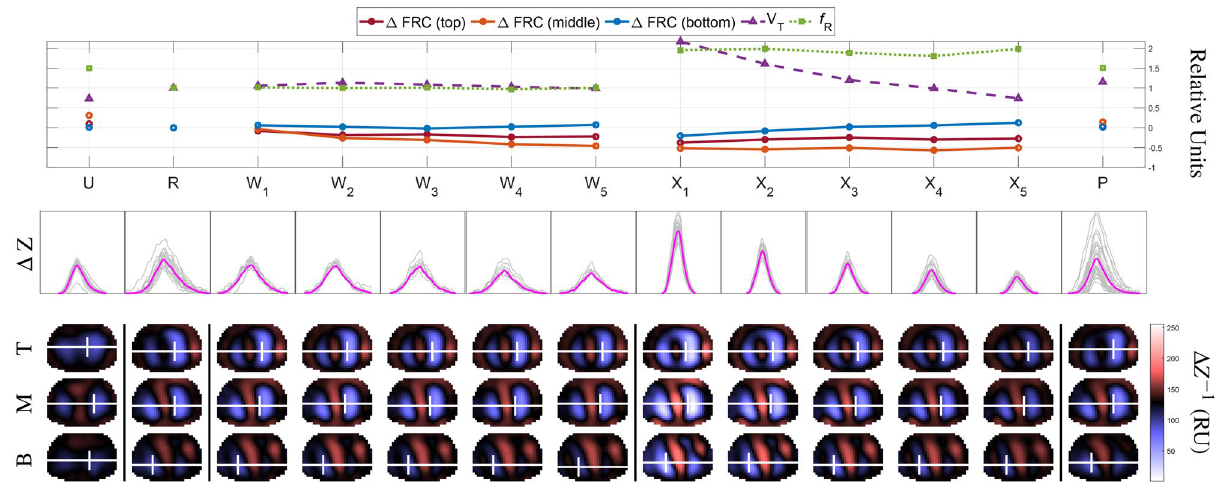
Figure 2. Detailed results for a single subject in the control posture. Experimental phases are labelled as in Fig. 1. Each column in phases W and X were 1-min periods, while phase U, R, and P were a 2-min periods. (Top) plots of (cid:31) FRC the top (red), middle (orange), and bottom (blue) reconstruction planes, V T (purple), and f R (green) for each phase. Error bars were omitted for clarity. Inter-subject variability is shown in Figs. 3 and 4. (Middle) accepted breaths for each phase are plotted in gray along with the average breath in magenta ( (cid:31) Z = impedance change from reference frame). All breaths across phases were plotted on the same scale. (Bottom) the internal conductivity distributions for the top (T), middle (M), and bottom (B) reconstruction planes for 1 each phase, with the subject shown face-down. Conductivity ( (cid:31) Z − ) values were scaled across phases, with lower conductivity values corresponding to larger volumes of air in the lungs. The center of ventilation for each reconstruction plane is shown with a white crosshair. The colour bar indicates relative conductivity from low (blue-white) to high (red-white).